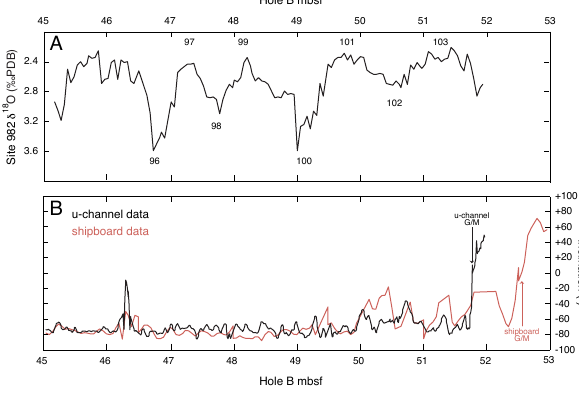
Figure 5 Fig. 5. ODP Site 982 benthic δ 18 O and shipboard and u-channel- derived magnetization directions for Hole 982B, core 6H vs. me- ters below sea floor (mb.s.f.), which preserves evidence of the Gauss–Matuyama (G/M) paleomagnetochronozone reversal. Ship- board inclination data are preliminary derived after only AF demag- netization at peak fields of 25mT (Channell and Lehman, 1999). U-channel (inclination) data are component magnetizations based on regression from alternating field demagnetization at peak fields of 80 and 70mT and 60 to 20mT (in 5mT steps), as described in Channell and Guyodo (2004). Note, u-channel data were only measured on Hole B cores included in the shipboard splice. Based on the preliminary shipboard data, the G/M boundary in Hole B was identified at 52.55mb.s.f. (red label and arrow) (982B 6H 7H, 0cm, 58.02m composite depth, mcd; Channell and Lehman, 1999). Subsequent post-cruise u-channel analysis has identified the precise depth of the G/M chronozone boundary in Hole B at 51.77mb.s.f. (black label and arrow) (982B-6H-6 at 77cm, 57.29mcd; Channell and Guyodo, 2004), which corresponds well to our understanding of the temporal relationships between the G/M chronozone reversal and records of benthic δ 18 O (i.e., peak MIS 103; Ohno et al., 2012). stratigraphy (Fig. 2b and c). In the original assignment